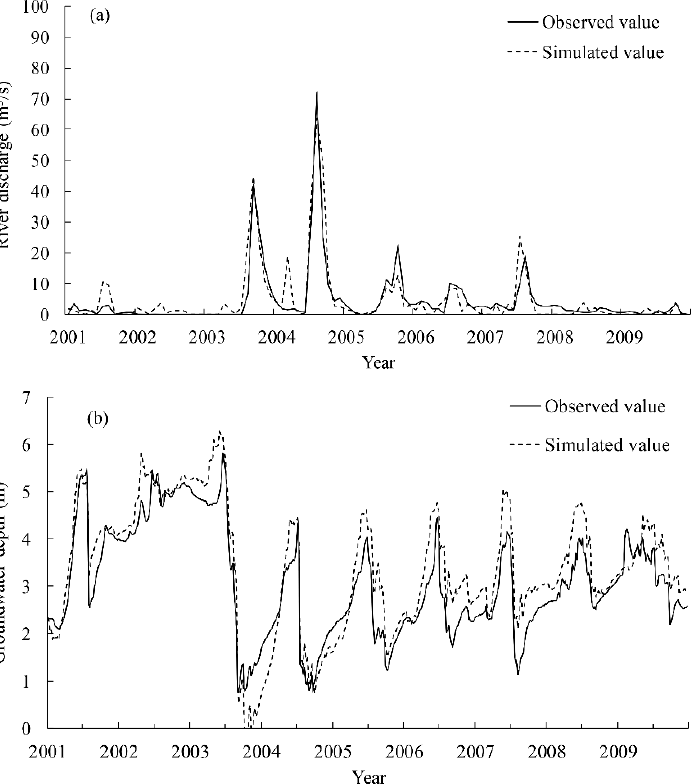
Figure 3. Comparison of the observed and simulated processes of ( a ) the river discharge and ( b ) the groundwater depth under maximizing the single-objective function NSE flow.